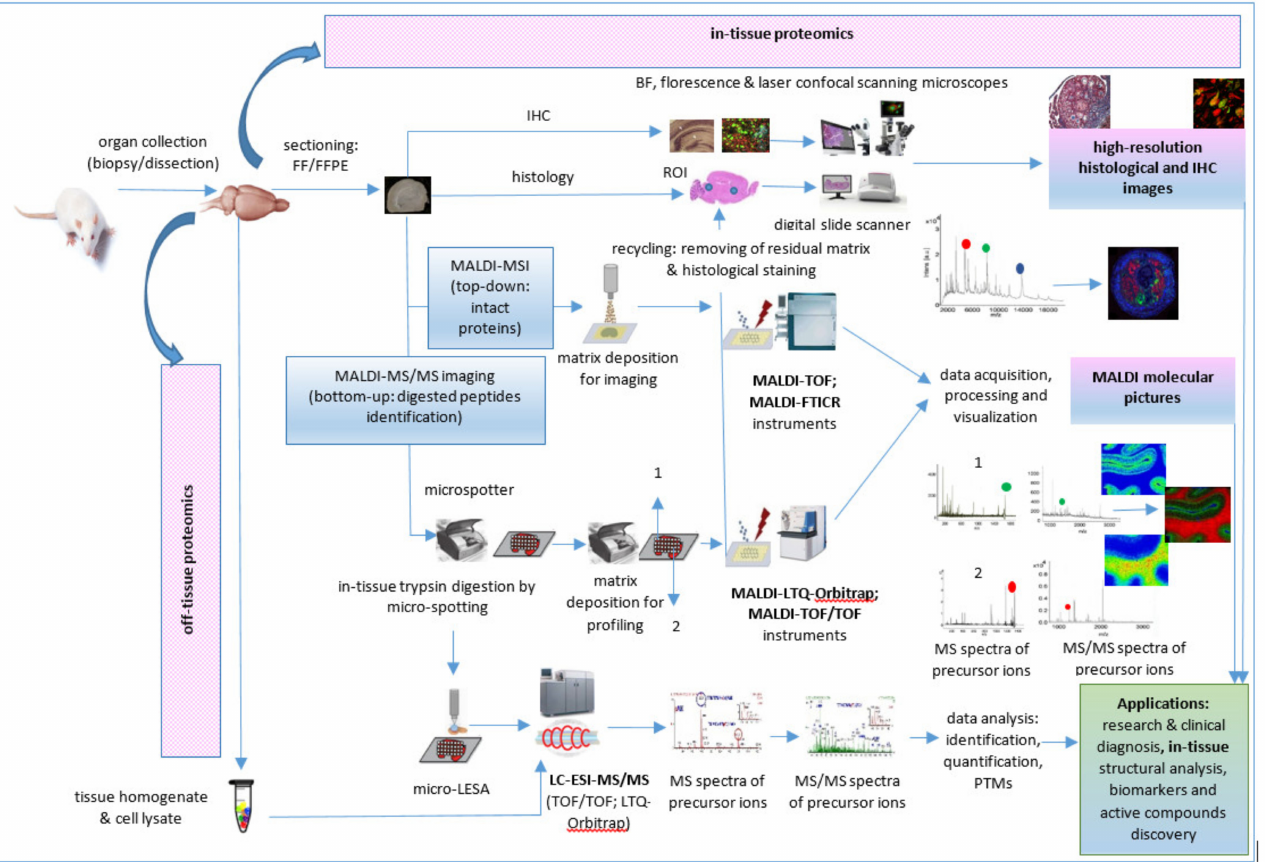
Figure 5. In-tissue proteomics workflow based on direct and tandem